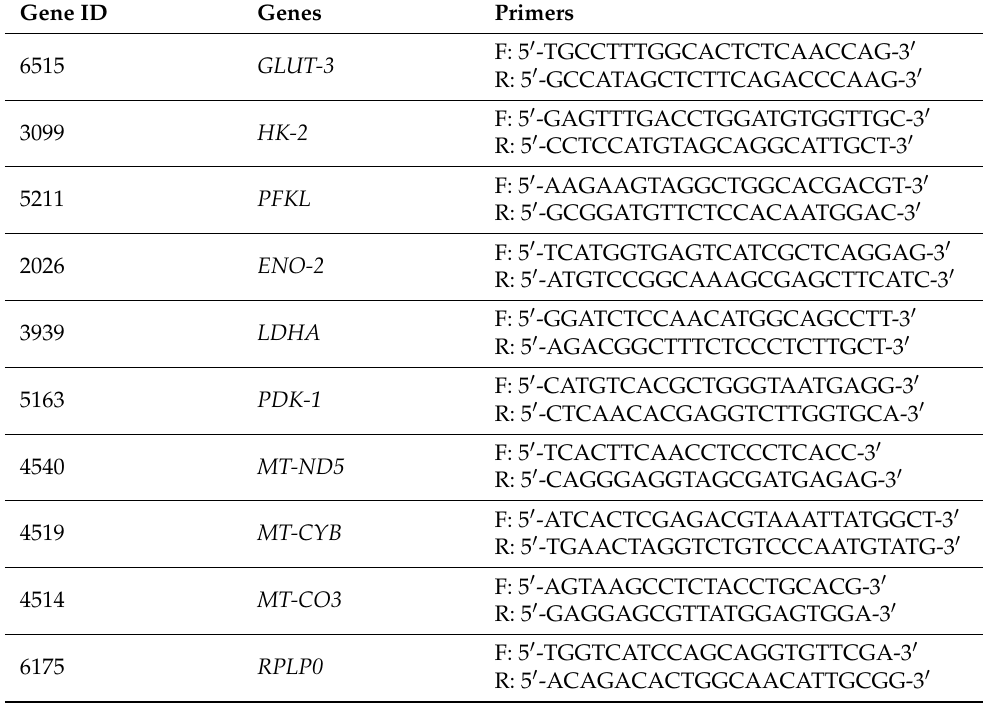
Table 1. Genes and primer sequences used for quantitative